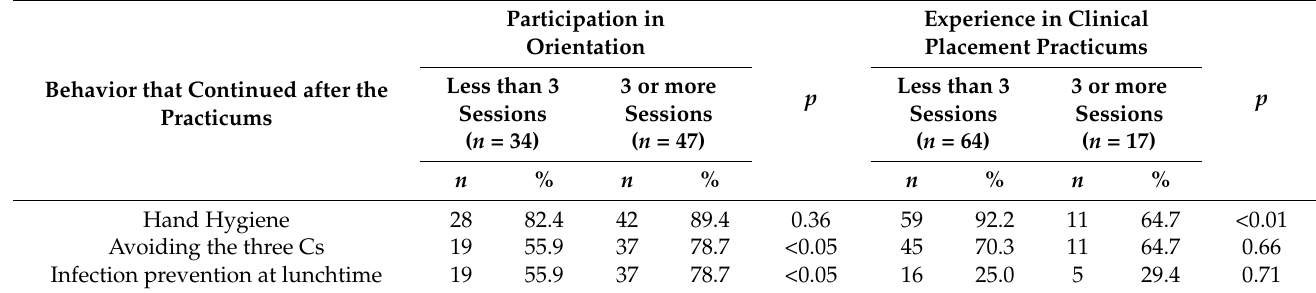
Table 7. A comparison of IPBs that were continued after the practicums, according to the number of pre-practicum orientations attended and experience in clinical placement